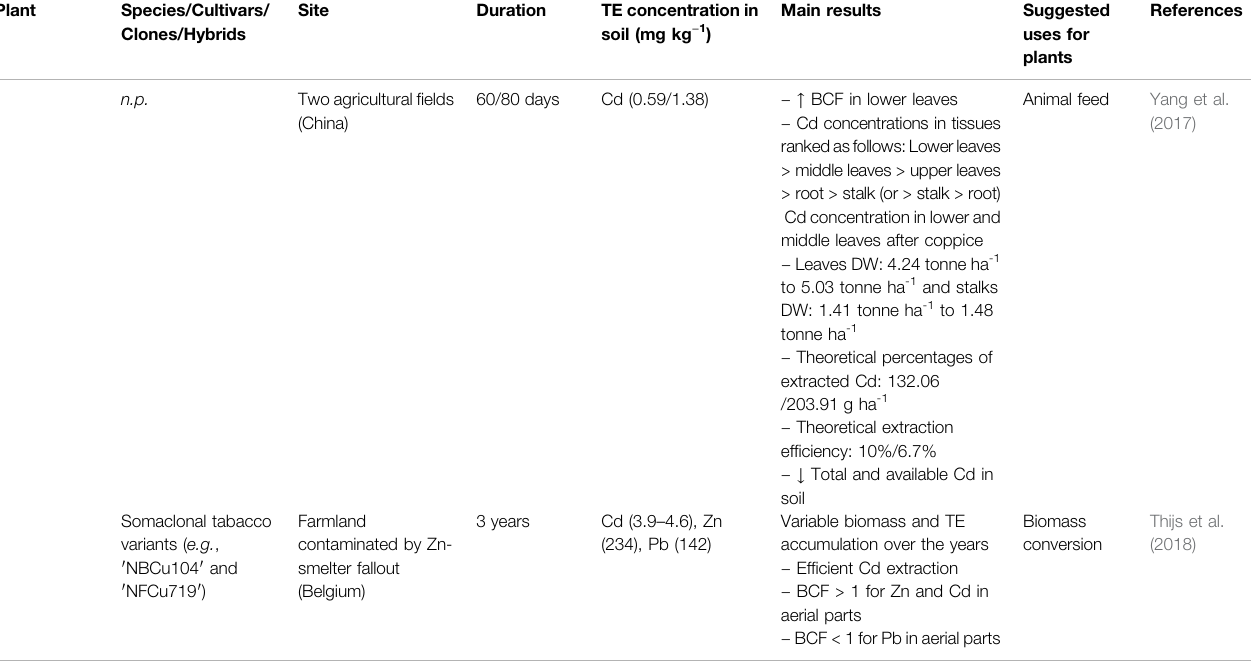
TABLE 1 | ( Continued ) Examples of fi eld trials with economically valuable annual crops (sun fl ower, maize, tobacco).